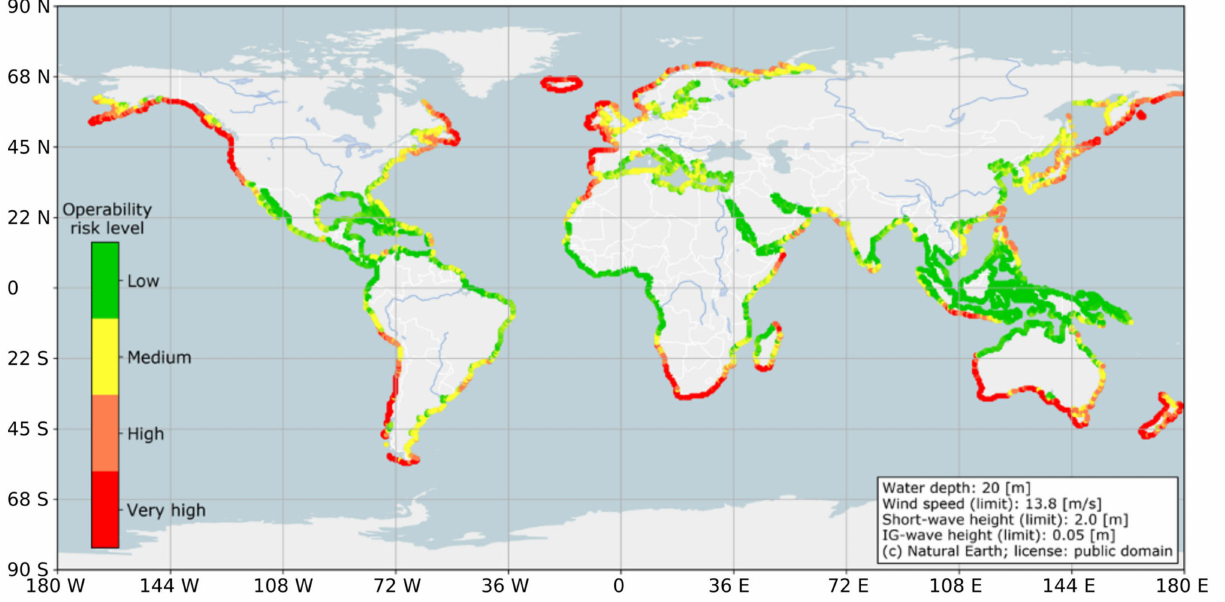
Figure 5. Geographical overview of port operability risk levels. Input/thresholds used in the method are given in the lower right